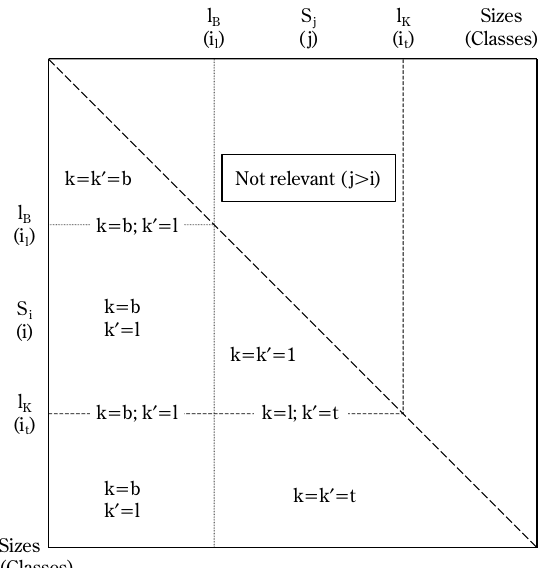
Fig. 2 Different types of collisions and consolidation processes of agglomerates as a function of the sizes of the mother parti-